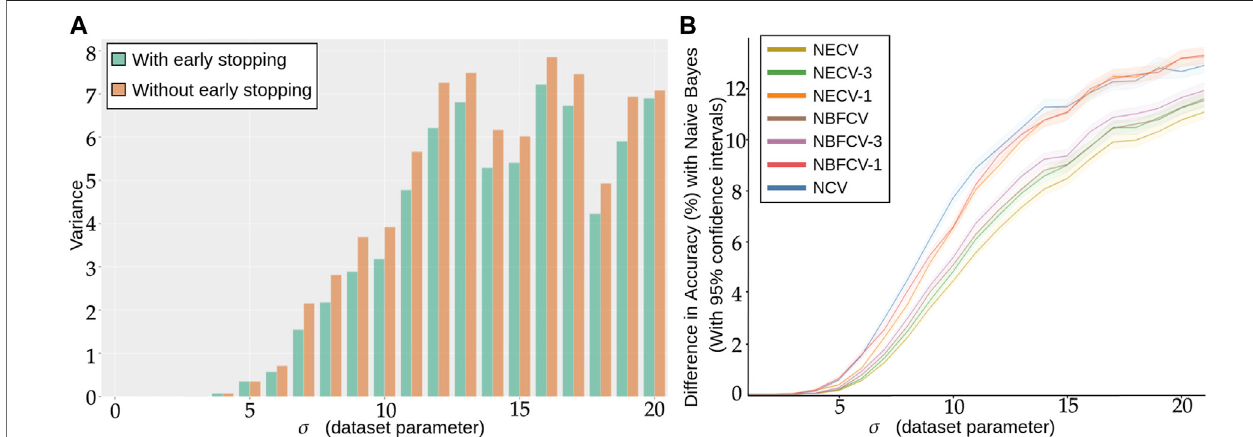
FIGURE 7 | (A) Repeated training, with and without early stopping: (A) Performance Variance, as measured on an independently simulated test set, (B) Comparison of models trained with NCV, NECV and NBFCV. On the y -axis we have the difference in accuracy between the Naive Bayes model and a given validation approach.Asthedatadistributionisknown,theNaiveBayesisatheoreticalupperlimitoftheachievableperformance.Curvesareshownwith95 % con fi denceintervals. A lower curve implies a better score.